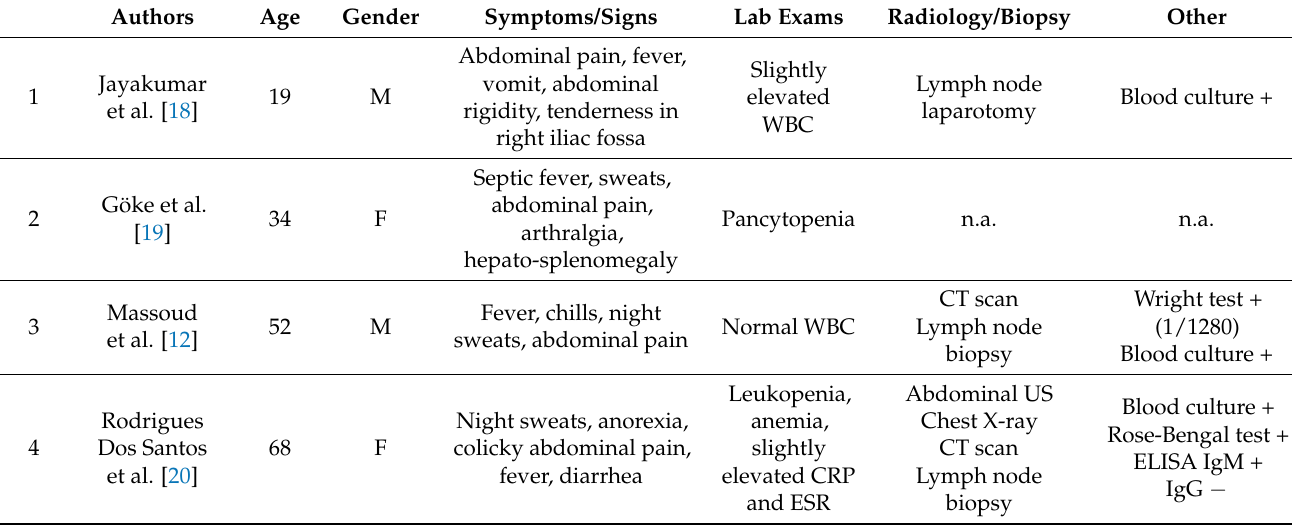
Table 3. Cases of isolated abdominal lymphadenopathies associated with brucellosis reported in the literature (chronological order). (Abbreviations: CRP: C-reactive protein; CT: Computed tomography; ELISA: Enzyme Linked ImmunoSorbent Assay; ESR: Erythrocyte sedimentation rate; IgM: Immunoglobulin M; IgG: Immunoglobulin G; WBC: White blood cell; M: Male; F: Female; n.a.: Not